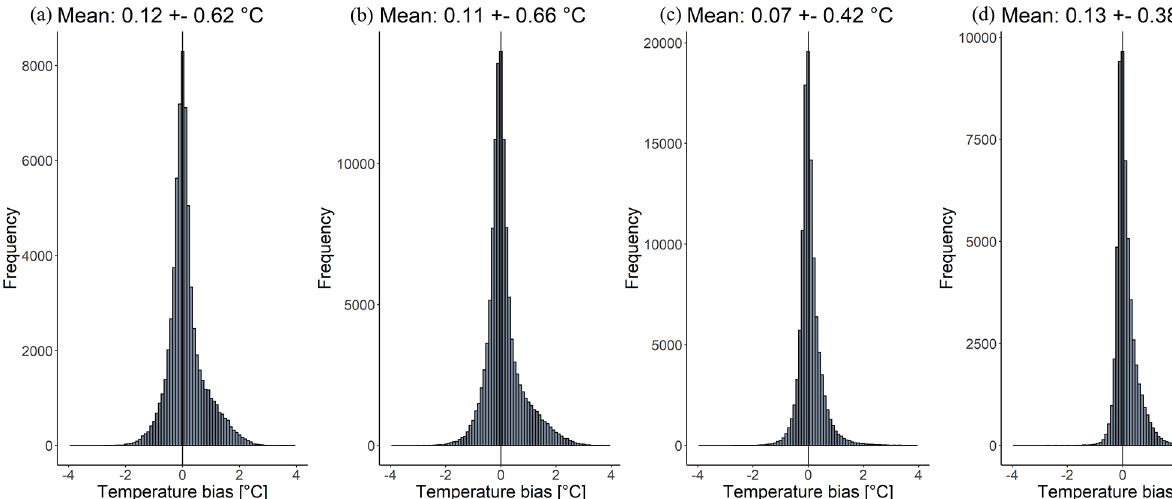
Figure 13. Same as Fig. 9 but for QC level 2.